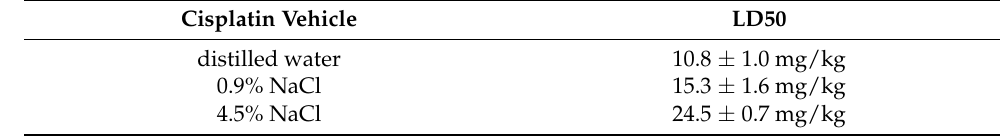
Table 5. Effect of cisplatin vehicle on cisplatin toxicity/mortality